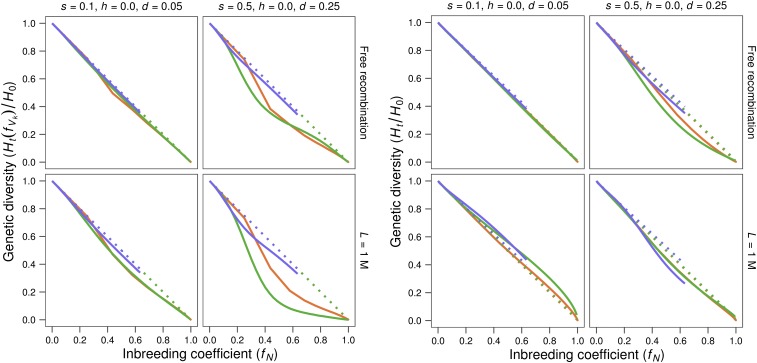
Relative neutral genetic diversity against inbreeding expected just from the census. The four left panels show the relative neutral genetic diversity expected in the lines on the basis of the observed variance of gametic contributions [Ht(fVk)/H0]. The four right panels show the observed relative neutral genetic diversity. In both cases, relative neutral genetic diversity is plotted against the corresponding inbreeding expected from the census (fN). The different panels correspond to two different deleterious effects (s) with completely recessive gene action (h = 0), and assume free recombination or a genome length of L = 1 Morgan. Red: N = 2; green: N = 10; blue: N = 50. Solid lines: lines maintained under the MSD scenario. Dotted lines: lines maintained under the MD scenario.